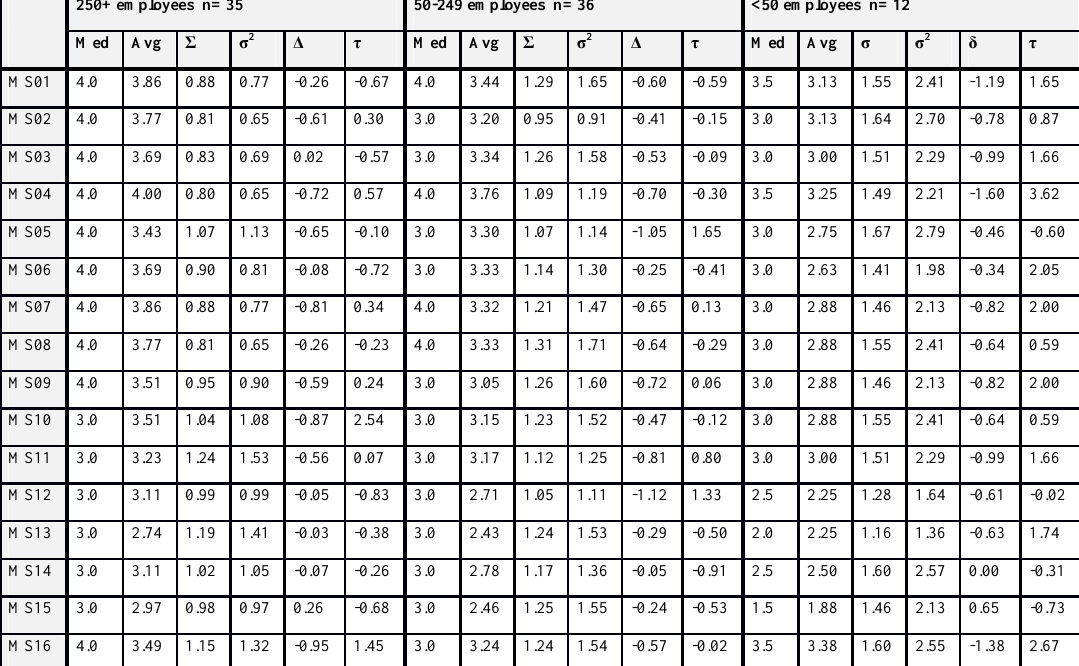
Table 7 – Companies Requirements on the Role “Enterprise Architect” According to the Number of Employees source: